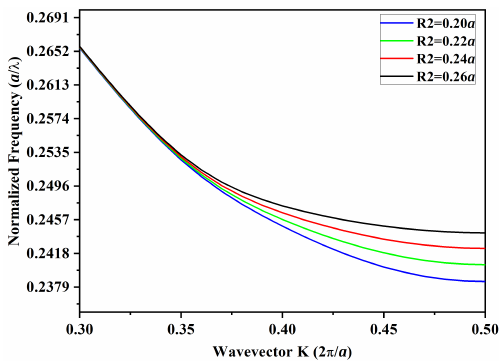
Figure 3. Dispersion profiles of the guided mode for various